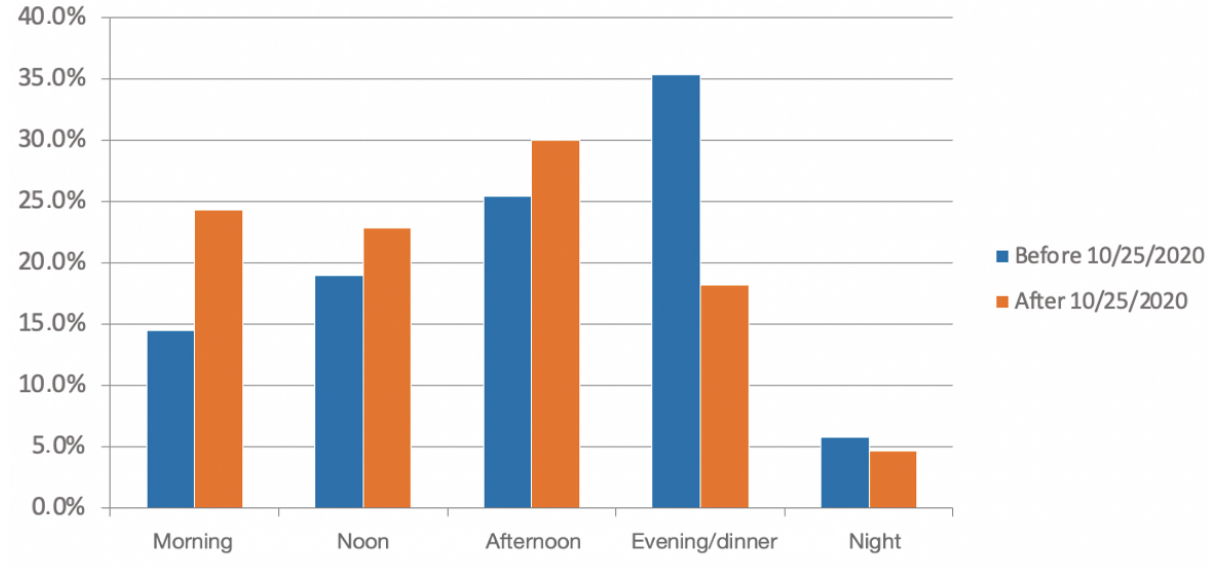
Figure 3. Contamination circumstances before and after the partial lockdown, which was triggered in France on October 25, 2020. Answer to the question “When do you think the contamination occurred?” ( P